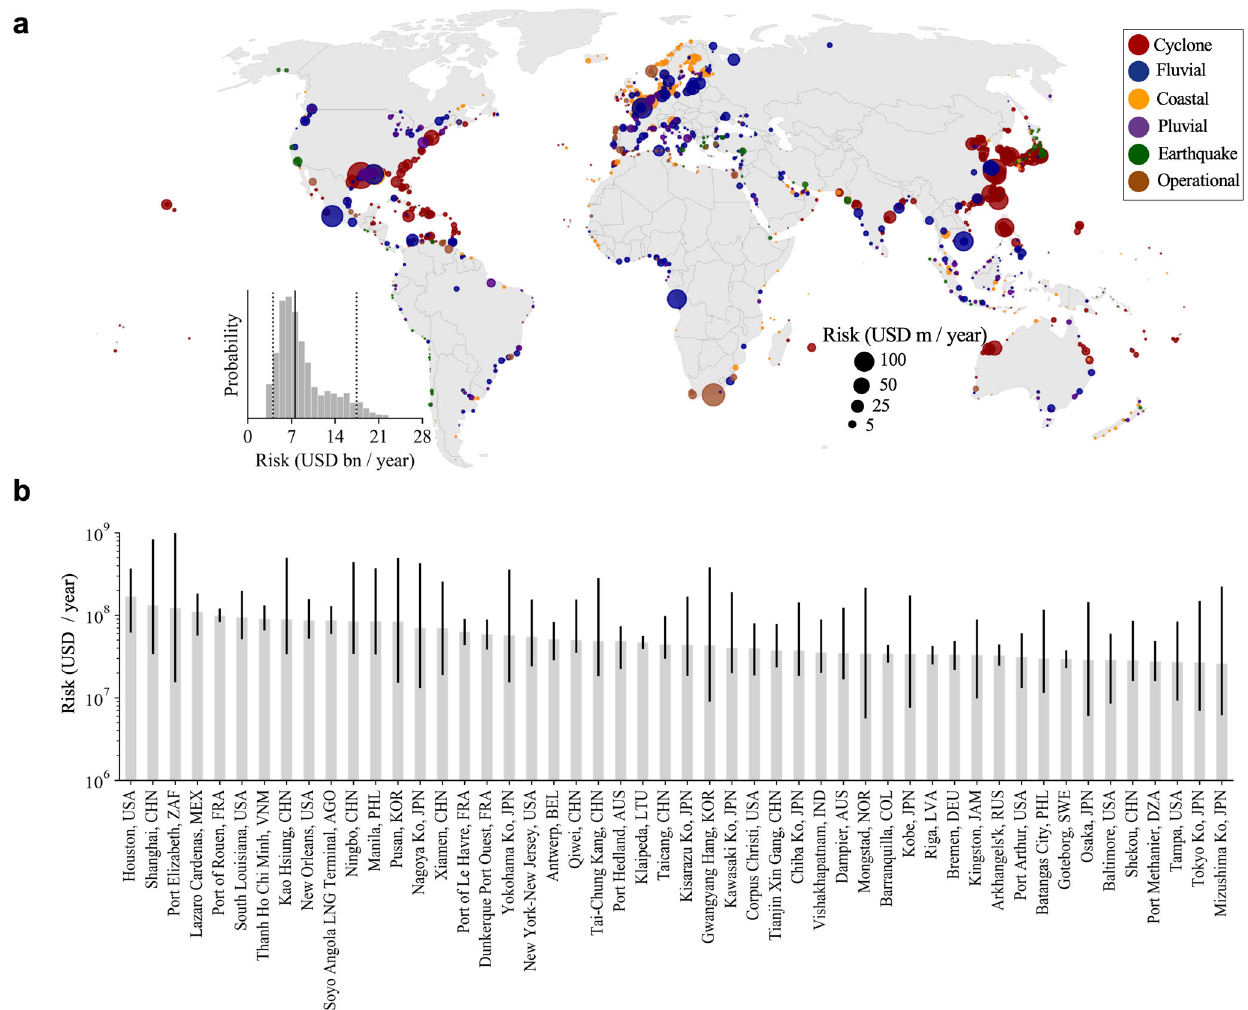
Fig. 1 Global footprint of port-speci fi c risk. a The median risk per port is expressed in USD m per year, with the colour indicating the dominant hazard. The histogram illustrates the globally aggregated risk across the 10,000 samples, with the black line indicating the median and the dashed lines indicating the 5th and 95th percentiles. b The top 50 ports in terms of median expected risk (bars). The error bars re fl ect the 5 – 95th percentile of the risk estimates based on the 10,000 samples. Note the logarithmic y